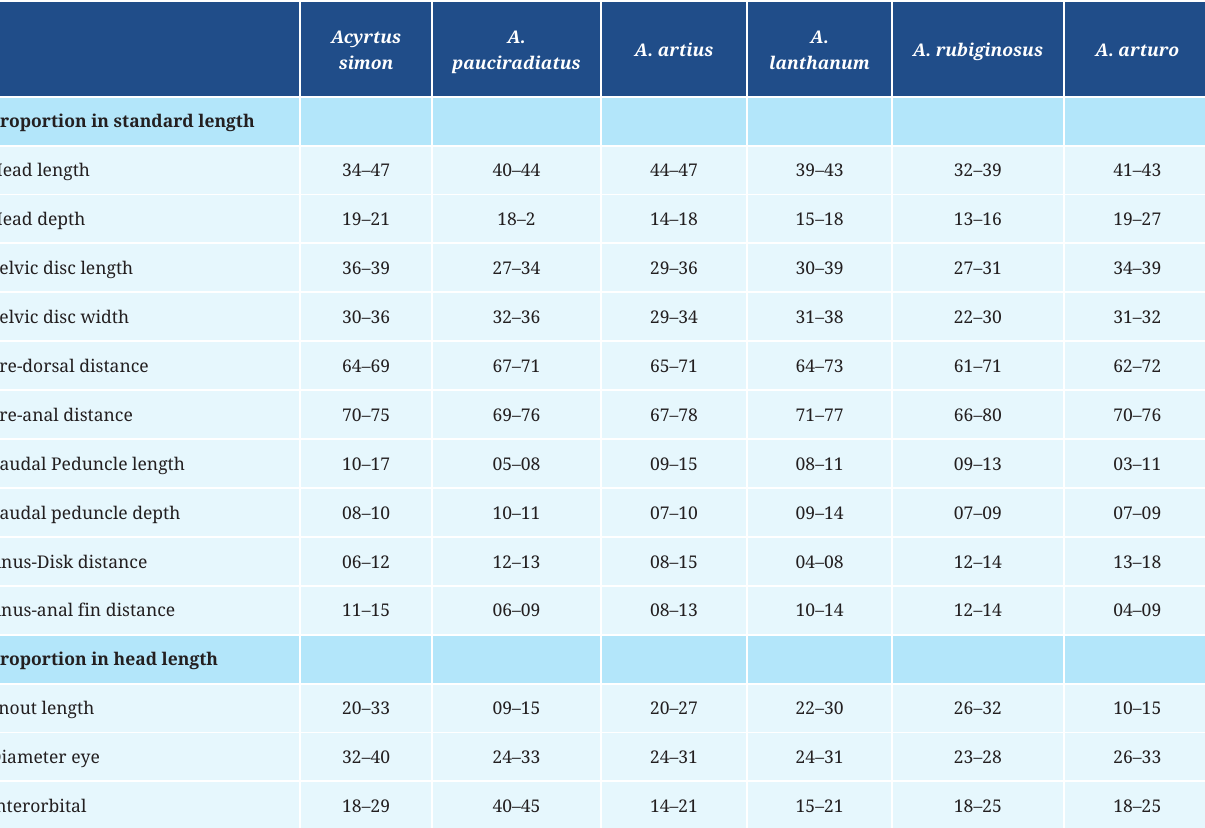
TABLE 2 | Measurement comparisons among Acyrtus species. Data for A. simon and A. pauciradiatus were obtained in the present study. Data for A. artius , A. lanthanum, and A. rubiginosus were taken from Conway et al . (2014), and A. arturo from Tavera et al.